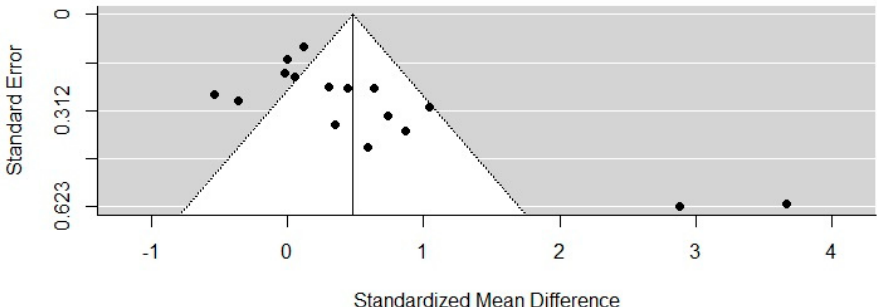
Figure 3. A funnel plot of the included studies.